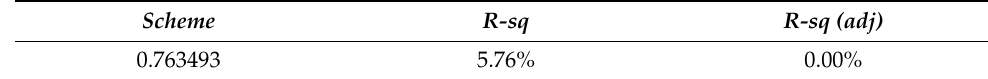
Figure 14. Individual value plot of lean vs. gender .